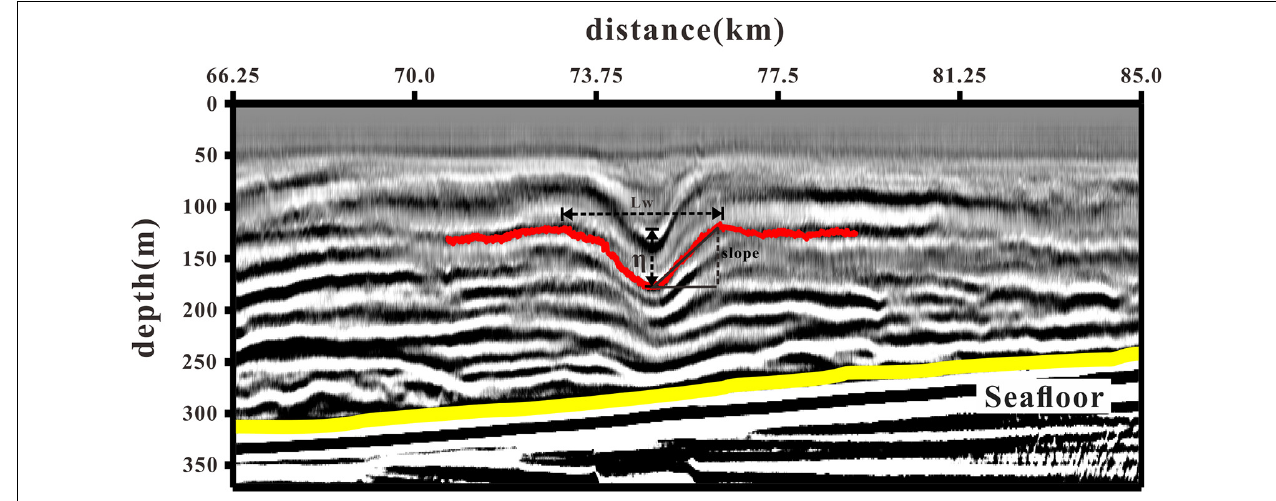
FIGURE 2 | Schematic diagram of amplitude ( η ), wavelength (Lw), and the slope of the leading and trailing edges (slope) calculation. The red line is one of the seismic events. The yellow line indicates the seafloor.